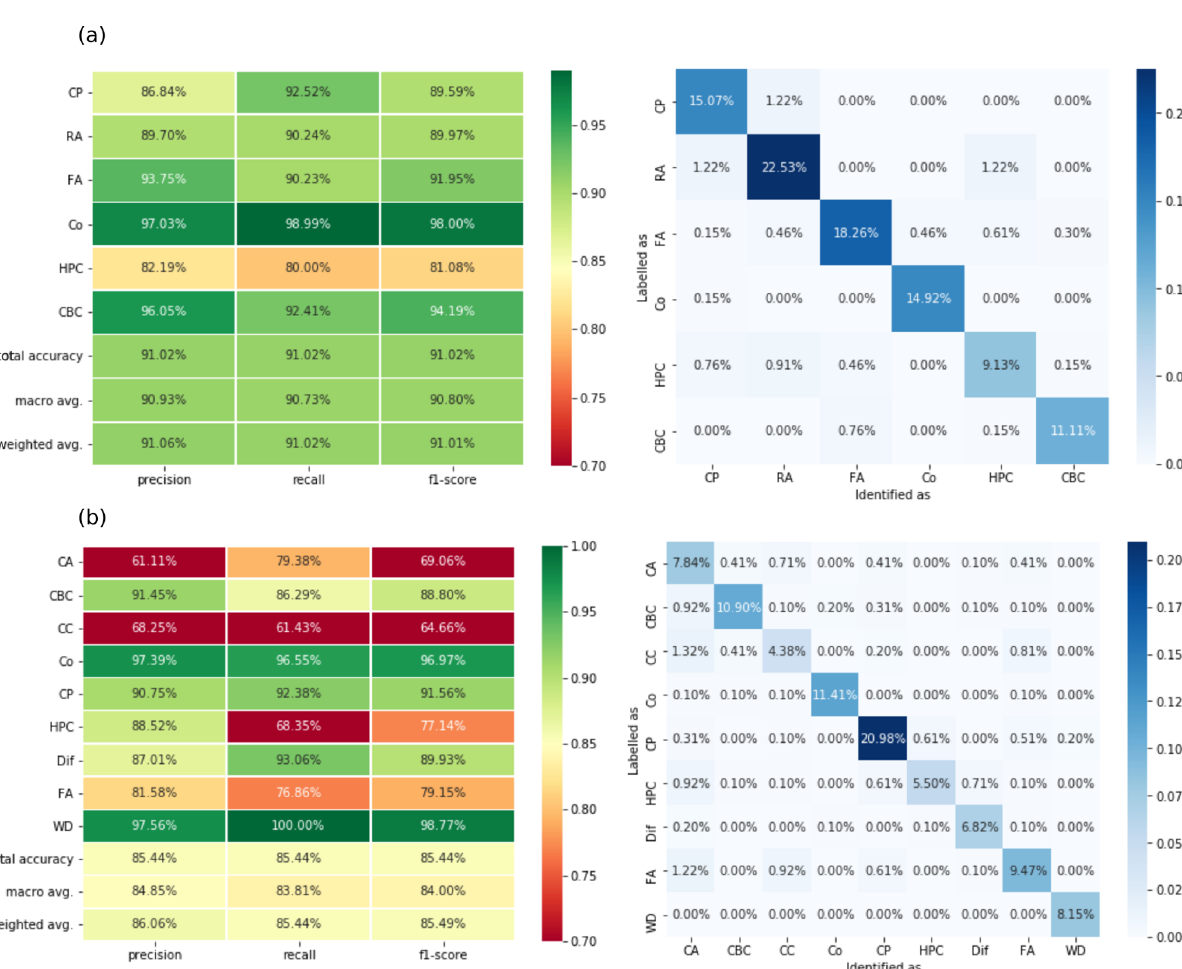
Figure 4. Evaluation of training for each probe with an independent test set. (a) Left, classification report (PIP) obtained for the corresponding test set. Right, confusion matrix (PIP) obtained for the corresponding test set; values on the diagonal correspond to samples correctly classified. (b) Left, classification report (2DS) obtained for the corresponding test set. Right, confusion matrix (2DS) obtained for the corresponding test set. The matrix values are normalized so that they sum up to